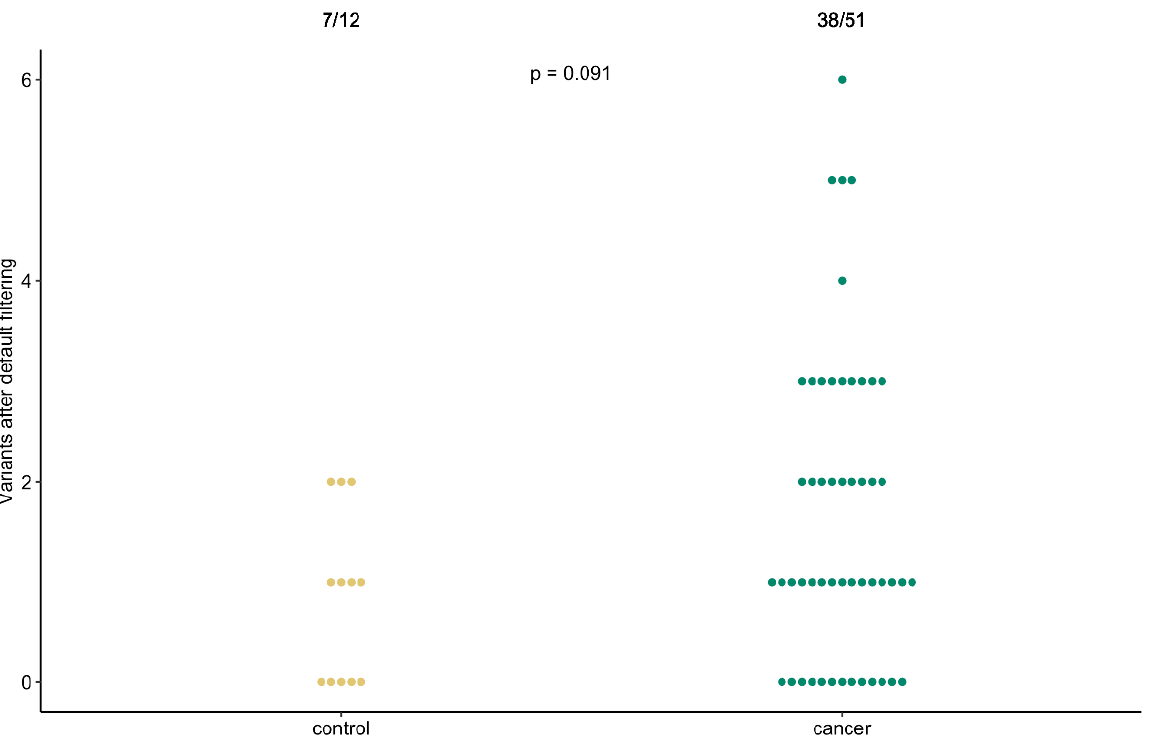
Figure A1. Default variant filtering cannot significantly distinguish patients from controls. Overall variant detection in control (yellow) and cancer (green) patients using default filtering. Beeswarm plots represent the number of somatic variants reported for a sample. The detection rate and Pearson correlation coefficient are given at the top.